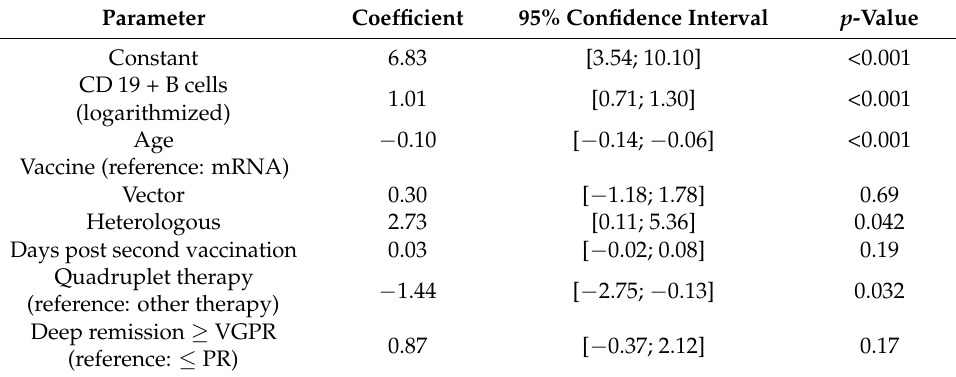
Table 2. Multiple linear regression of factors associated with logarithmized antibody titers in mye- loma patients.